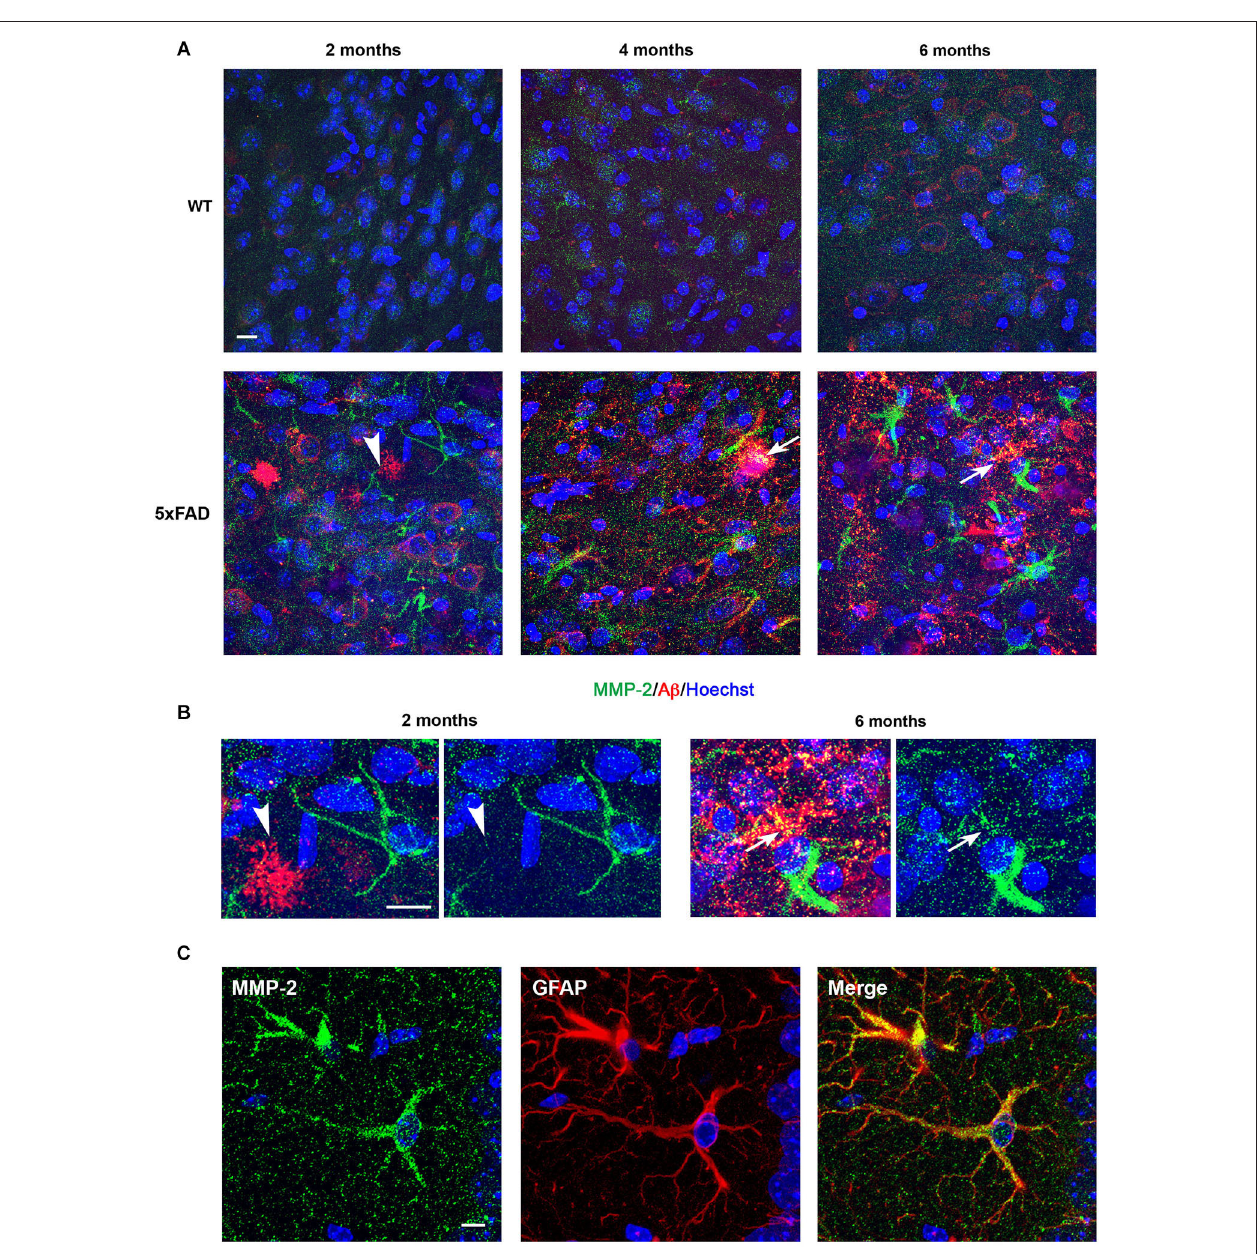
as early as 2 months. MMP-2 immunostaining increases with age in 5xFAD mice, and at 4 and 6 months there is partial colocalization with amyloid plaques, as revealed by yellow color (arrows). (B) High power magnifications of 5xFAD subiculum at 2 and 6 months showing non-association and association of MMP-2 with amyloid deposits, respectively. Hoechst (blue) labels cell nuclei. (C) Confocal microphotographs showing localization of MMP-2 (green) to GFAP+ astrocytes (red) of 5xFAD mice. Scale bars: 10 µ m.